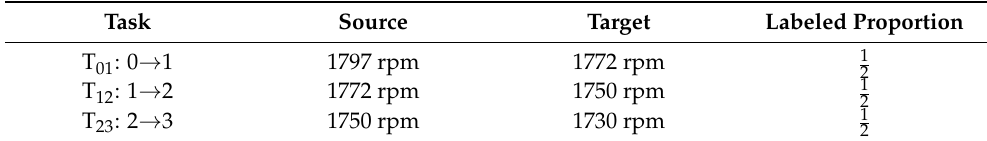
Table 3. Partial details of fault diagnosis tasks in this case.